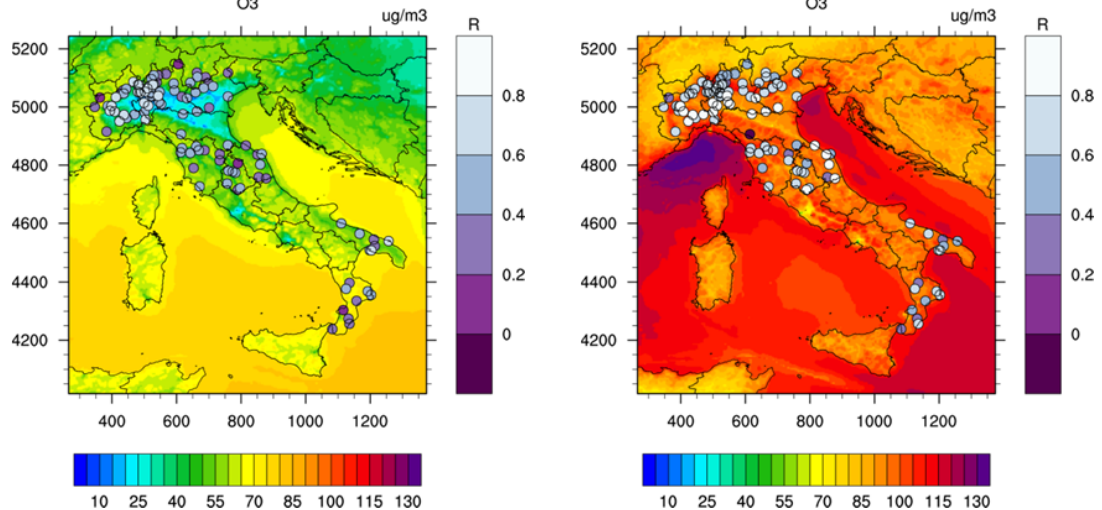
Figure 10. O 3 —Monthly average of model concentrations of January (left) and August right) for the Base configuration, overlaid with monthly values of MMB (upper panel) and R (lower panel) at monitoring stations. Model concentrations have a horizontal colour bar ( µ g / m 3 ), skill scores have a vertical colour bar (non ‐ dimensional).